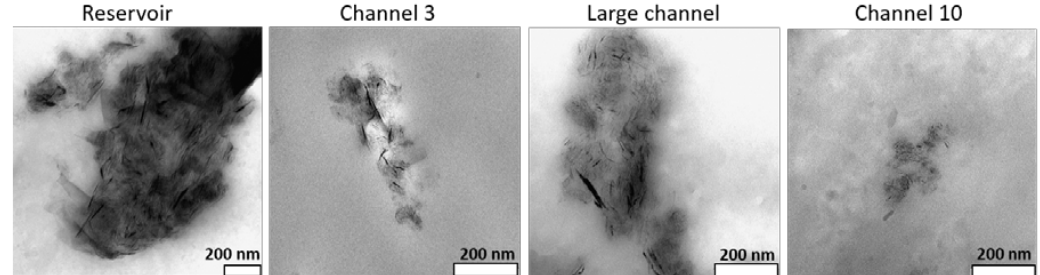
Figure 4. TEM micrographs of the GnPC composite collected along the extensional mixer. Table 3. Characterization of dispersion and re-agglomeration of PP nanocomposites containing 2 wt